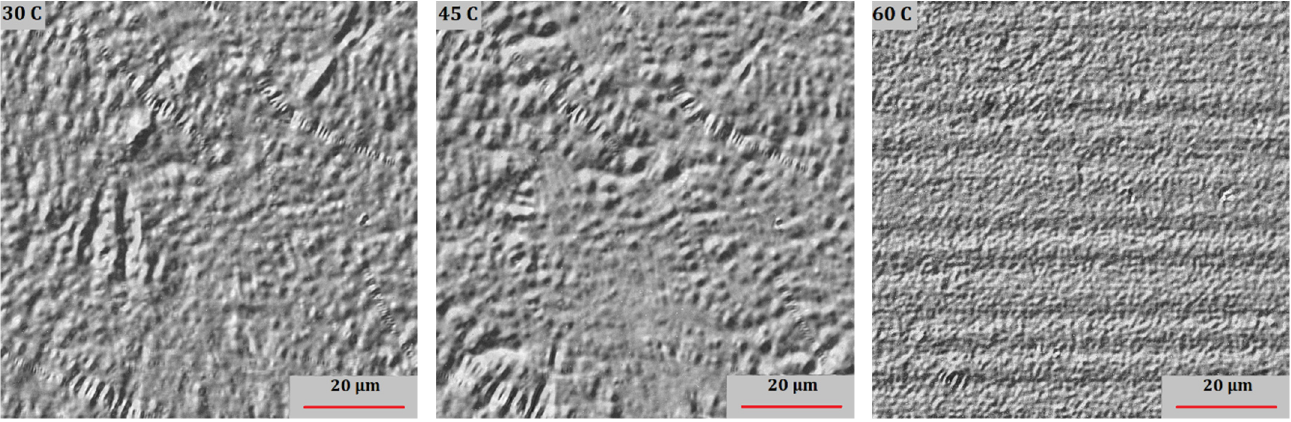
Figure 8. CLSM-DIC images of bitumen A at selected temperatures during the fast heating scan (1.25 °C/min).